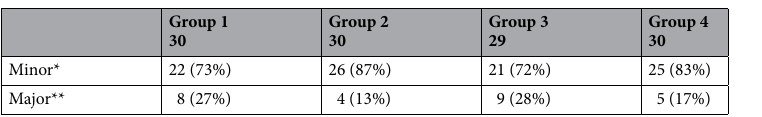
Table 3. Comparison between major and minor surgeries according to study groups*. *Minor surgeries: Cystectomy, Salpingectomy, Unilateral/Bilateral salpingo-oophorectomy. **Major surgeries: Hysterectomy, Myomectomy, Endometrioma resection. * p Value = 0.34.